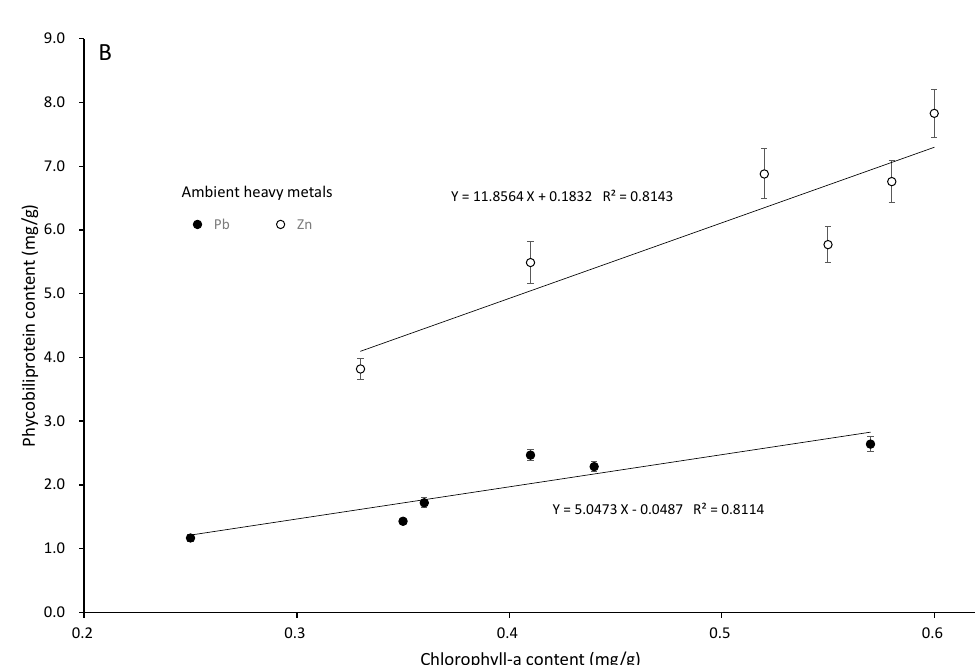
Figure 7. The relationship between chlorophyll-a (mg/g) and heavy metal levels (lead and zinc, µ g/g) in S. suiae ( A ). The relationship between phycobiliproteins (mg/g) and chlorophyll-a (mg/g) in S. suiae ( B ).